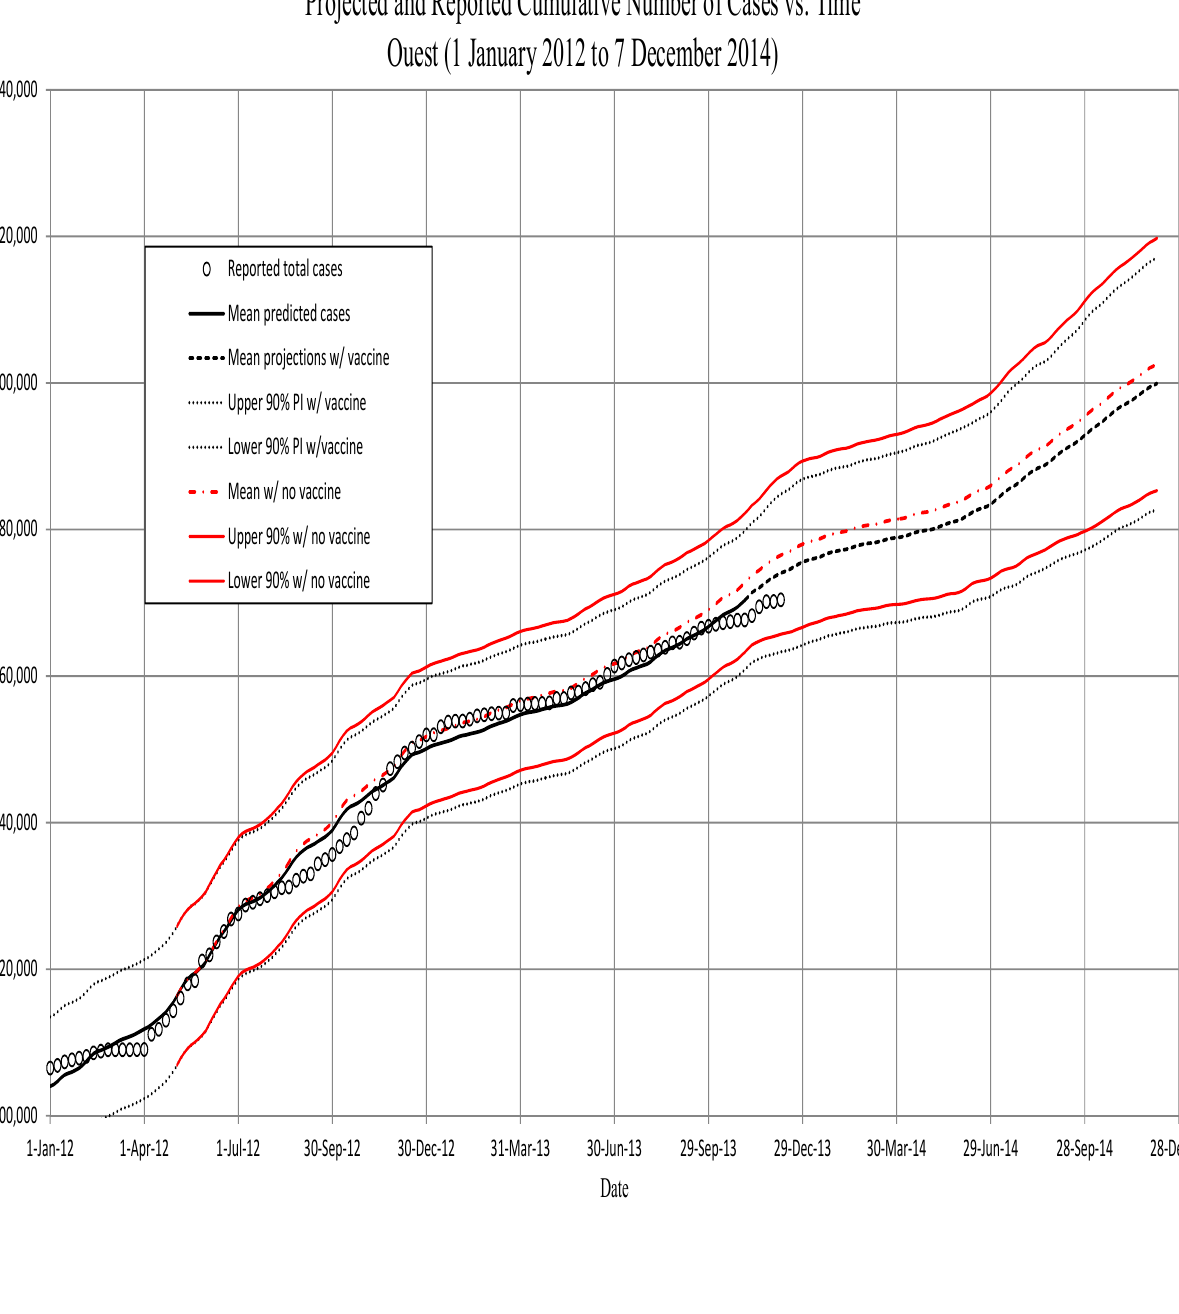
Figure 10. Ouest. The projected total symptomatic individuals vs . time. Circles, observed; solid line, model prediction; dashed lines, fifth, 50th and 95th percentiles for model projections based on the past 13 years of precipitation records. The red lines are model runs with vaccination schedule that occurred in spring, 2012 (see text). The slow down in growth in late February and March was before the vaccination program